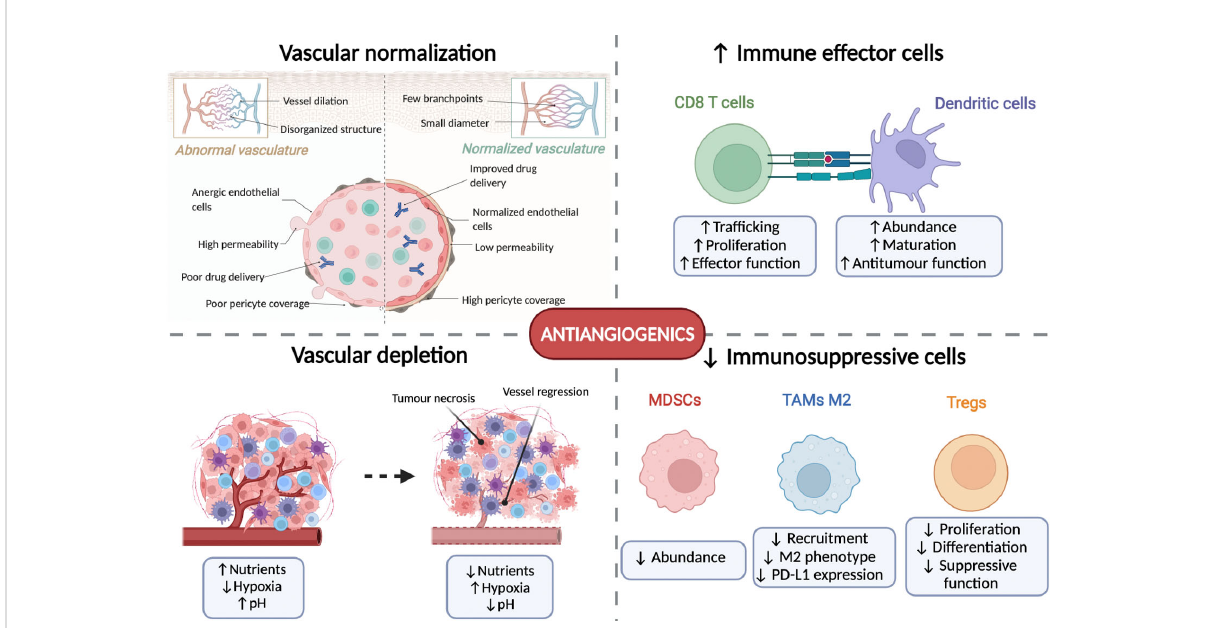
FIGURE 2 Mechanisms of action of antiangiogenic agents. Antiangiogenics exert their anti-tumoural effects via four axes. First, they induce normalisation of the tumour vasculature which improves drug delivery and oxygenation. Second, they induce vascular depletion which induces tumour starvation and necrosis. Thirdly, they favour an antitumour immune response by increasing the proliferation and activation of CD8+ T cells and dendritic cells. Finally, they decrease the presence and function of immunosuppressive cells including myeloid-derived suppressor cells (MDSCs), tumour-associated macrophages (TAMs) and T regulatory cells (Tregs). Figure generated with